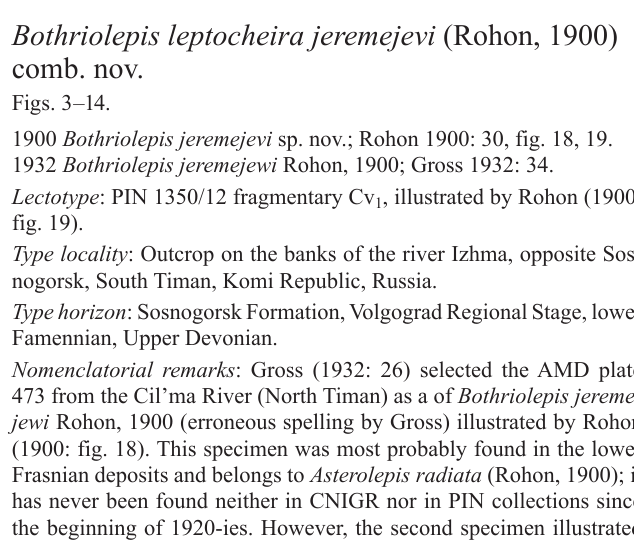
Fig. 3. Antiarchan fish Bothriolepis leptocheira jeremejevi (Rohon, 1900), Sosnogorsk locality, Sosnogorsk Formation, lowermost Famennian, separate plates and parts of articulated head shields. A . Articulated Nu, left Pn and left La plates IG KSC 155/90 in dorsal view. B . Disarticulated plates of the head shield IG KSC 155/150 in dorsal view. C . Part of articulated head shield IG KSC 155/162 in dorsal view. D . Imprint of the ventral wall of trunk armour and some skeletal elements of the head armour IG KSC 155/10-3 in ventral view showing suborbital and infragnathal bones. Abbreviations: AVL, ante- rior ventro-lateral plate; cir, semicircular pit-line groove; csl, central sensory line groove; d.end, opening of canal for endolymphatic duct; ifc 1 , principal section of infraorbital sensory line; IG, inferognathal; La, lateral plate; Nu, nuchal plate; mp, middle pit-line groove; Pn, paranuchal plate; Pp, postpineal plate; Prm, premedian plate; SO, suborbital plate; socc, supraoccipital cross-commissural pit-line